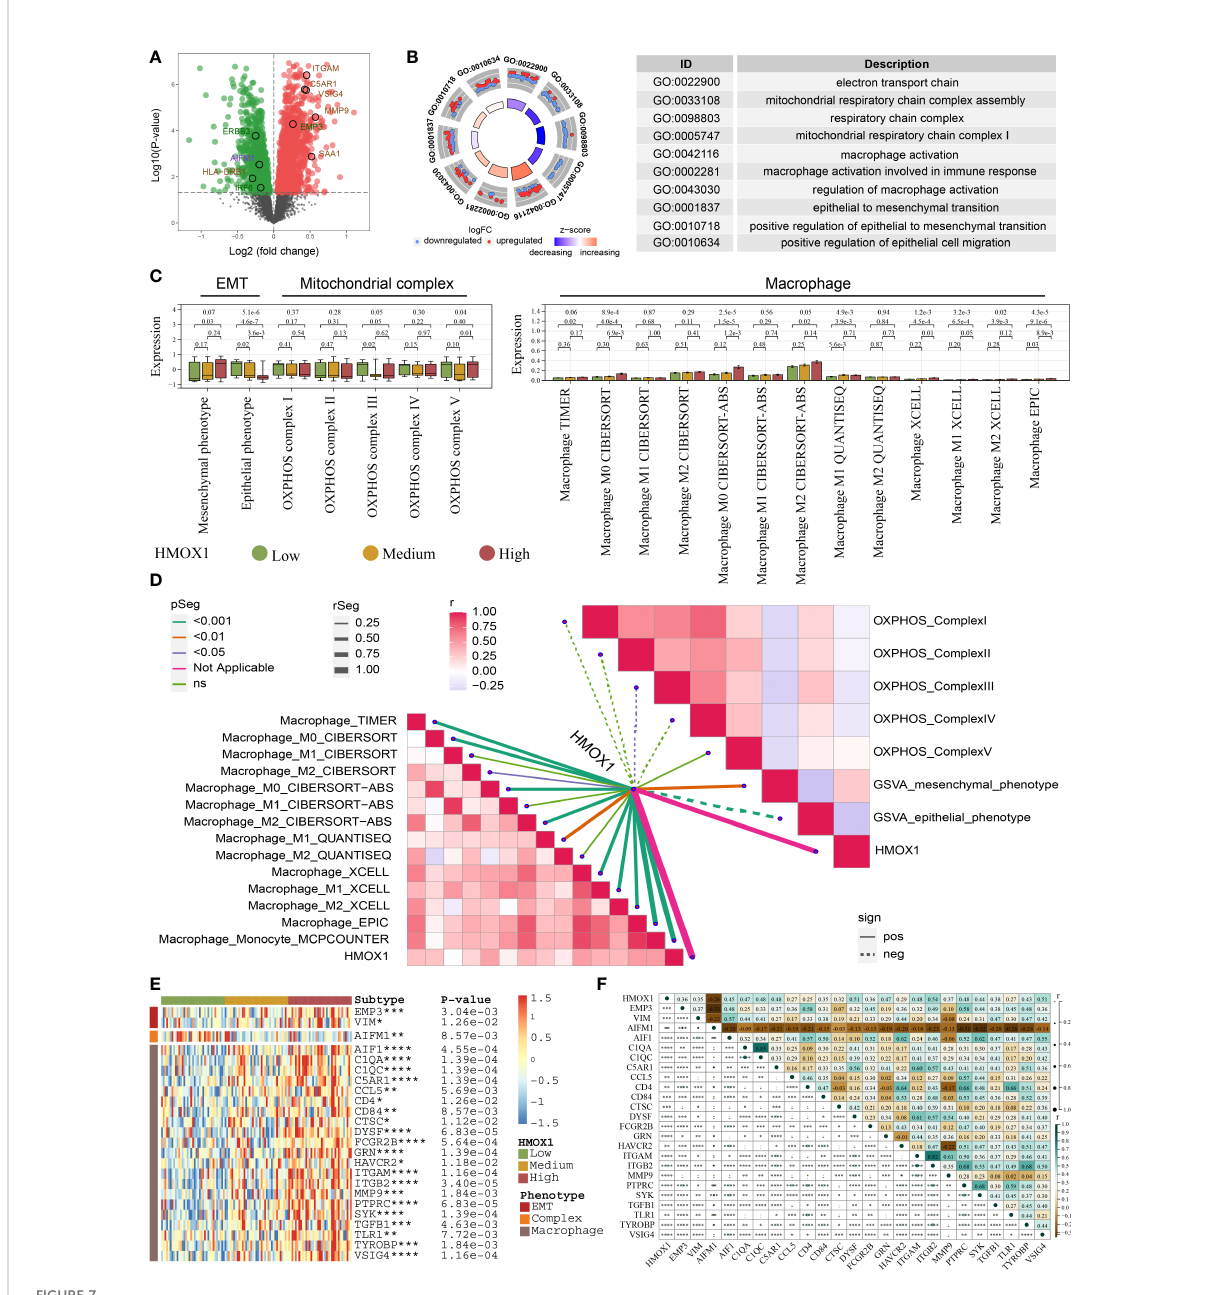
FIGURE 7 Proteomic validation for the HMOX1-mediated metastasis regulatory network in LUAD. (A) Volcano plots showing the differentially expressed proteins between the high and low HMOX1 groups. (B) GO enrichment for the differentially expressed proteins. (C) The difference in EMT, mitochondrial complex, and macrophage between the high, medium, and low HMOX1 groups. (D) Correlation between HMOX1 and EMT, mitochondrial complex, macrophage. (E) The difference in proteins of the HMOX1 regulatory network among high, medium, and low HMOX1 groups. (F) Correlation among proteins of the HMOX1 regulatory network *P < 0.05; **P < 0.01; ***P < 0.001; ****P <